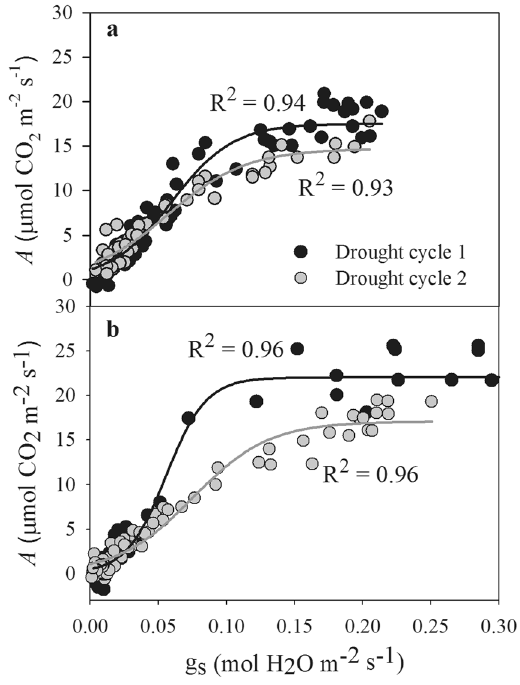
Figure 4. Relationship between A and g s during drought cycles 1 (black circles) and 2 (gray circles) in A. fruticosa ( a ) and R. pseudoacacia ( b ).